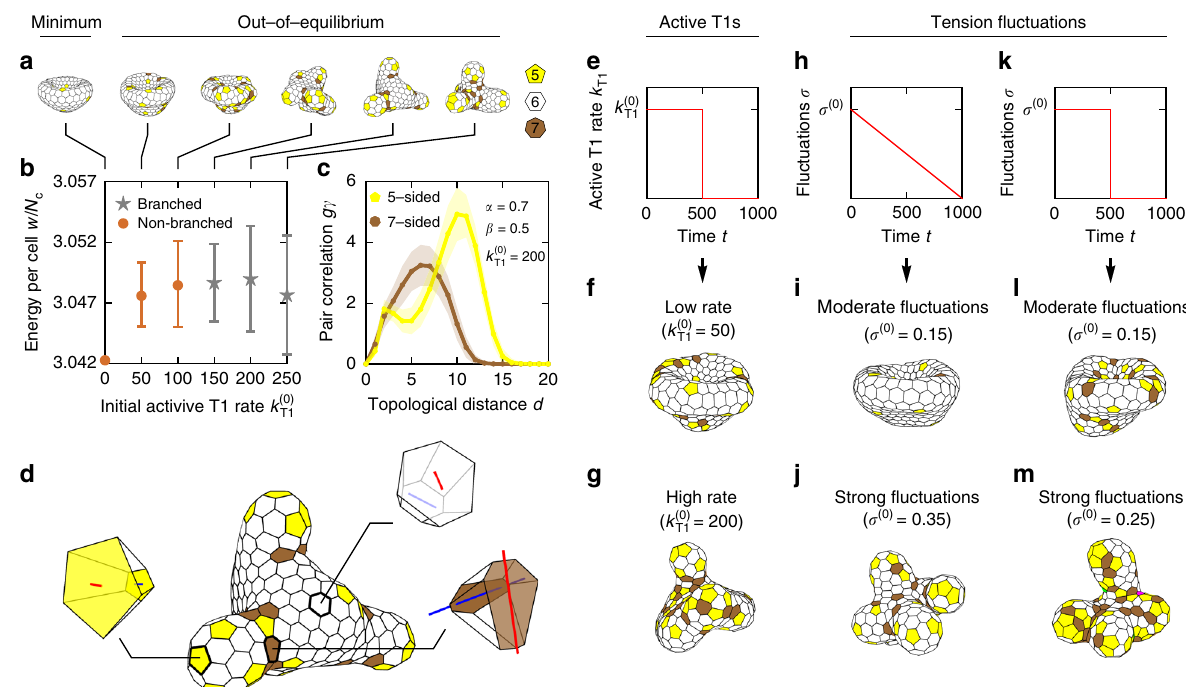
Fig. 2 High rate of active T1 transitions is necessary for formation of branched morphologies. a Sequence of α = 0.7, β = 0.5, N c = 300, and v = 100 shapes with k ð 0 Þ ¼ 0 ; 50 ; 100 ; 150 ; 200 ; and 250. Cells are color-coded according to polygon class; pentagonal cells are yellow, hexagonal are lumen T 1 white, and heptagonal are brown. b Energy of fi nal epithelial-shell shapes as a function of the initial active T1 rate k ð 0 Þ . Symbols and error bars represent the T 1 ¼ 0 the mechanics is completely deterministic and the arithmetic mean and the standard deviation of the energies over 100 instances, respectively; at k ð 0 Þ T 1 width of the error bar vanishes. c Distributions of topological distances between pairs of pentagons (yellow) and heptagons (brown) in the shell at k ð 0 Þ ¼ 200 ( fi fth shape from the left in panel a ). The symbols show the arithmetic mean of the pair correlation over 300 simulated instances, whereas the T 1 ¼ 200 shell is magni fi ed and the full 3D shapes of representative 5-, shaded areas represent the standard deviation. Solid lines guide the eye. In d , the k ð 0 Þ T 1 6-, and 7-coordinated cells are replotted with the long axes of their apical and basal sides indicated by blue and red lines, respectively; line lengths are ¼ 50 and 200 in case of a proportional to the anisometry of the side in question (see “ Methods ” section). Panels f and g show the model shapes at k ð 0 Þ T 1 step-like temporal pro fi le of the active T1 rate ( e ). In panels i and j , we present epithelial shells obtained within a model, where T1 transitions are generated by fl uctuations in line tension with a linear temporal pro fi le ( h ), the former for σ (0) = 0.15 and the latter for σ (0) = 0.35; panels l and m show shapes obtained with a step-like variation of the magnitude of fl uctuations ( k ) for σ (0) = 0.15 and 0.25,